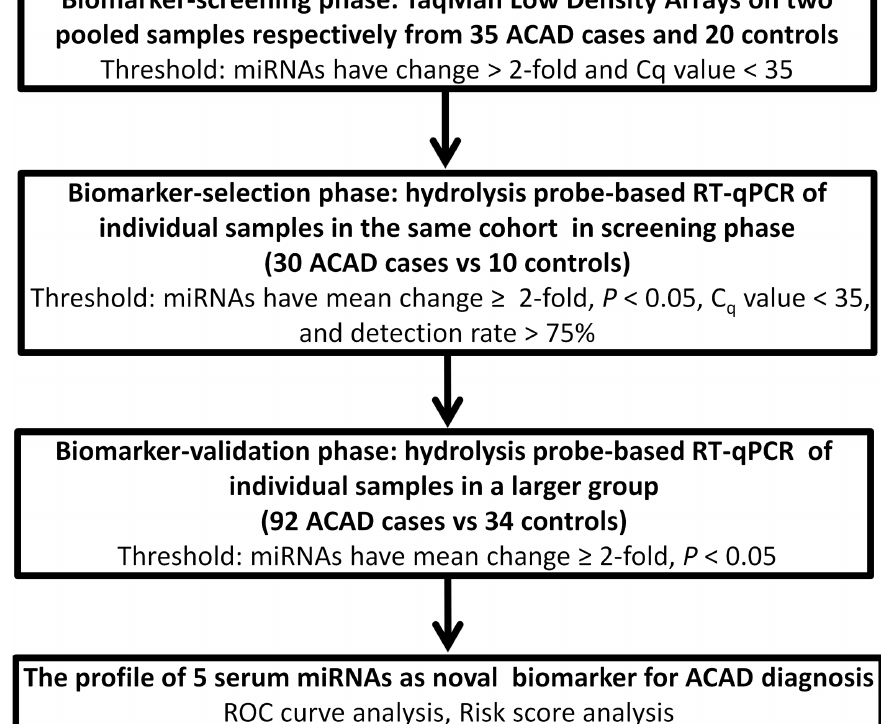
Figure 1. Overview of the experimental design.